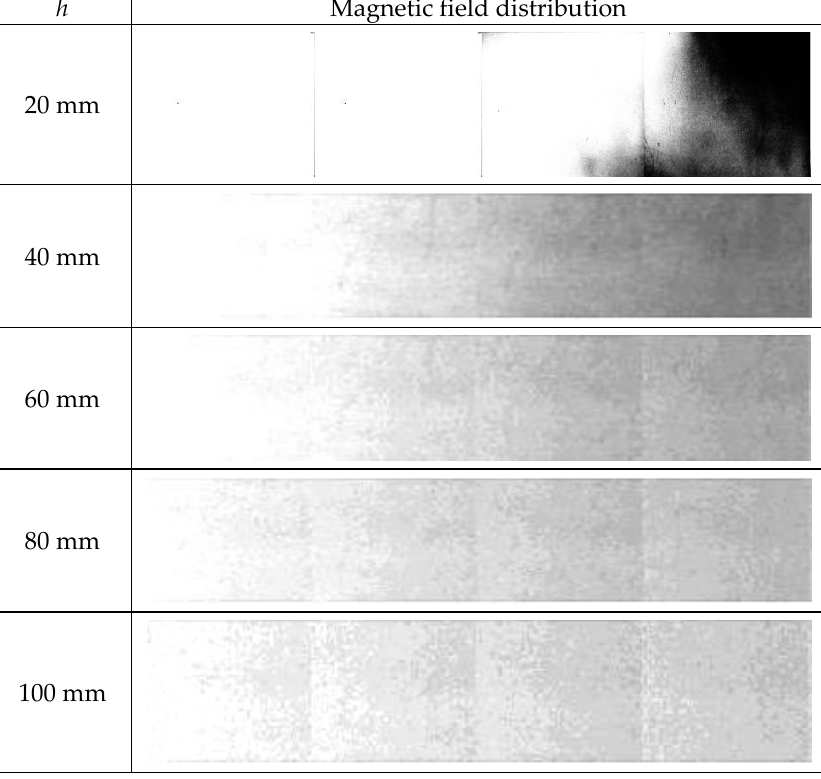
Figure 13. Magnetic field distribution measured with the MO-sensor for different concrete cover thicknesses; same pole magnetization; only half of the measurements are shown.